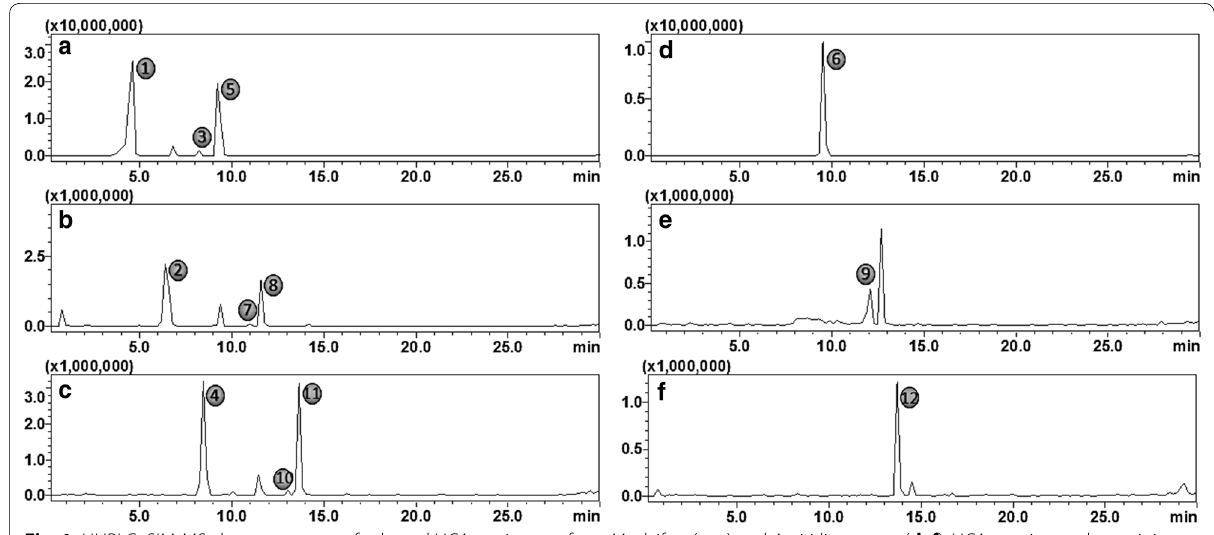
Fig. 1 UHPLC–SIM-MS chromatograms of selected HCA conjugates from M. oleifera ( a – c ) and A. viridis extracts ( d – f ). HCAs conjugated to quinic acid: a caffeoyl-quinic acids, b p -coumaroyl-quinic acid and c feruloyl-quinic acid. HCAs conjugated to isocitric acid: d caffeoyl-isocitric acid, e p -coumaroyl-isocitric acid and f feruloyl-isocitric acid